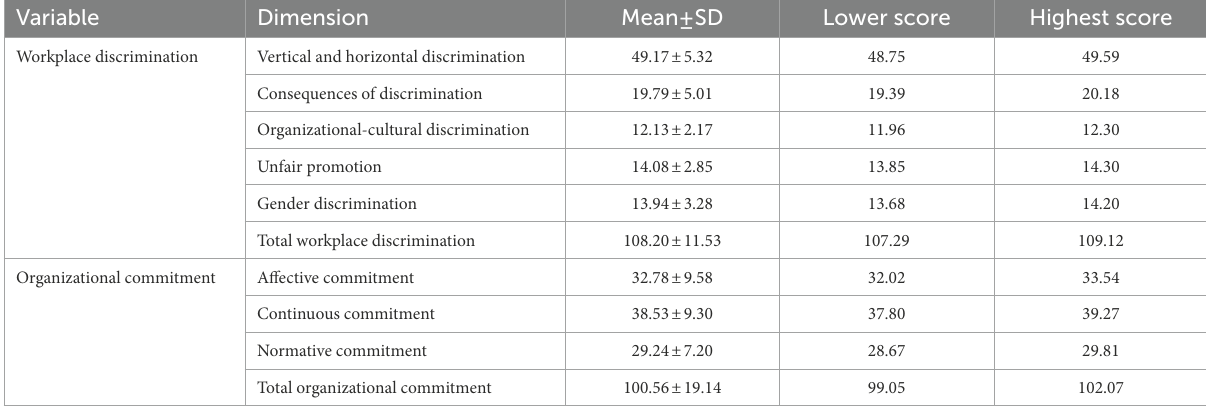
TABLE 2 Dimensions of workplace discrimination and organizational